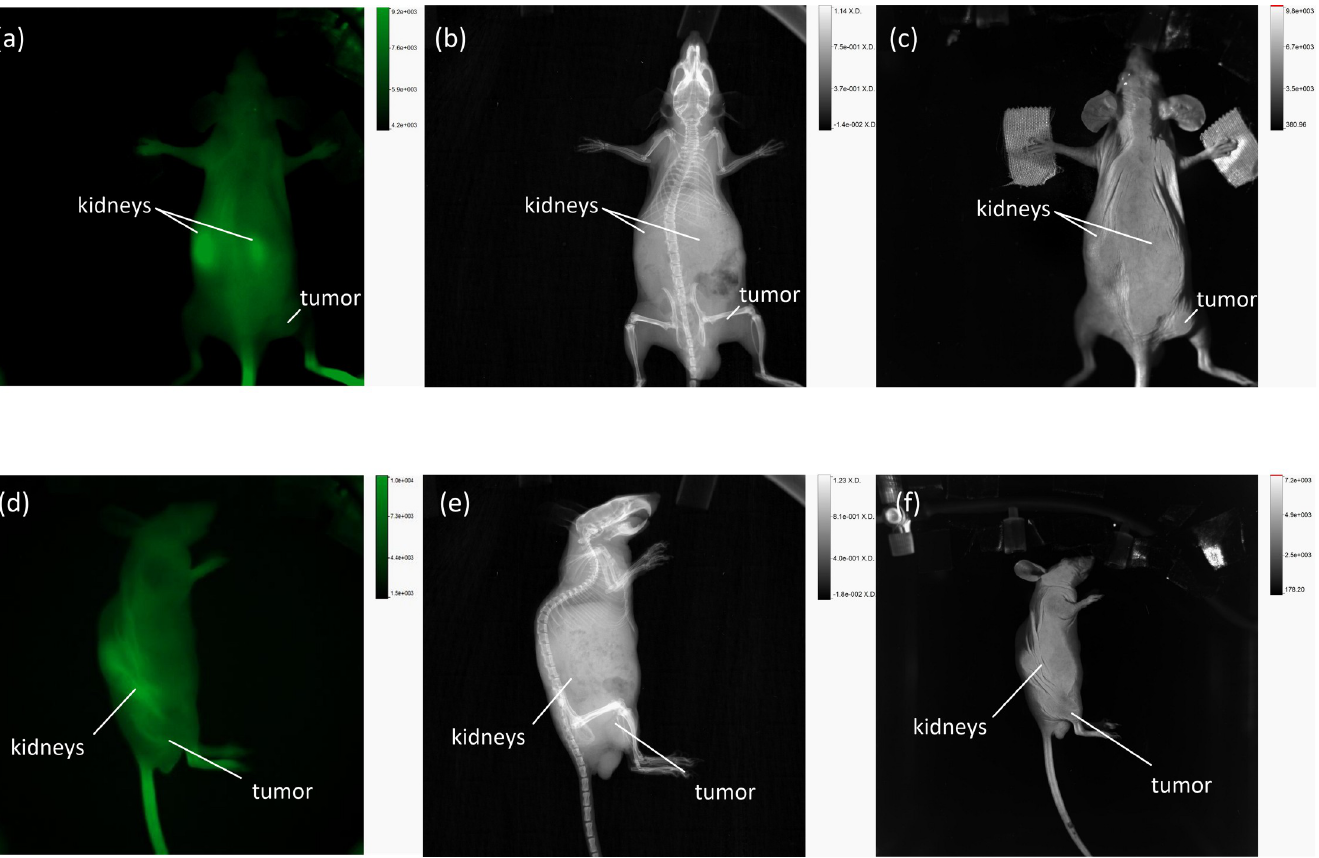
Fig 7. Fluorescence Imaging of AuNP-SIDAG-LUG at 3 h p.i. Using the In Vivo Xtreme System. (Fig 7A) Fluorescence image at an excitation wavelength of 750 nm to 790 nm. (Fig 7B) X-ray imaging. (Fig 7C) Bright field imaging. (Fig 7D) Fluorescence image at an excitation wavelength of 750 nm to 790 nm from the left side of the mouse. (Fig 7E) X-ray Imaging from the left side of the mouse. (Fig 7D) Bright field imaging from the left side of the mouse.